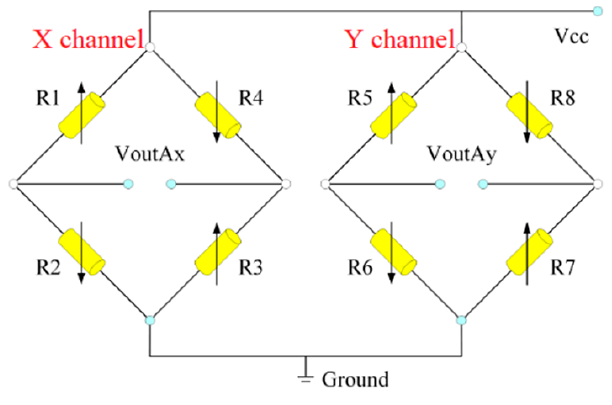
Figure 3. Wheatstone bridge.